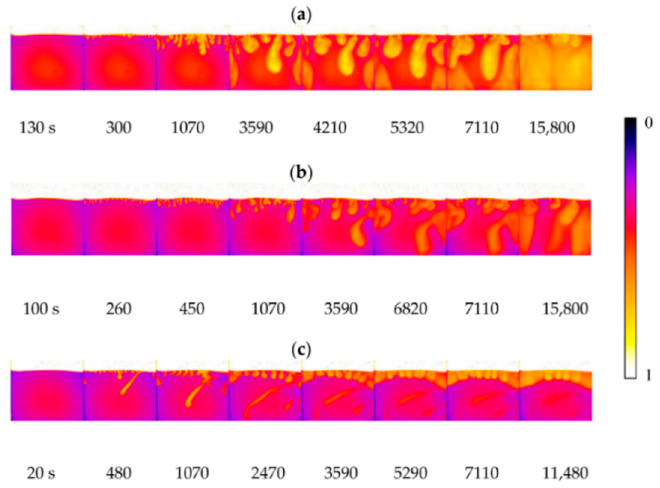
Figure 4. Time-lapse visualisation of CO 2 convective mixing (viscous fingering) into water, by Hele-Shaw setup at 33 °C at various salinities: ( a ) 0 wt%, ( b ) 0.25 wt% and ( c ) 1.00 wt% [107].